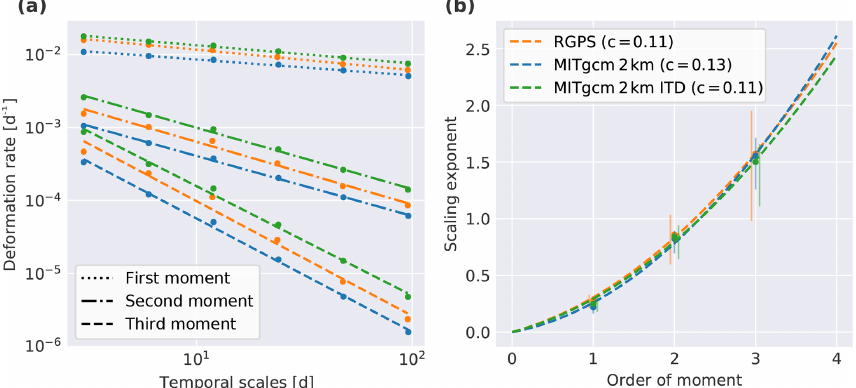
Figure 2. (a) The first three moments of sea ice deformation rate as a function of the temporal scale for RGPS and both model simulations. (b) The temporal scaling exponents as a function of the moment order. A quadratic structure function α(q) = cq 2 + dq is fitted (dashed lines). The curvature of the fit is given in the legend. The error bounds of the scaling exponents are determined by the minimum and maximum slope between successive points of the power law